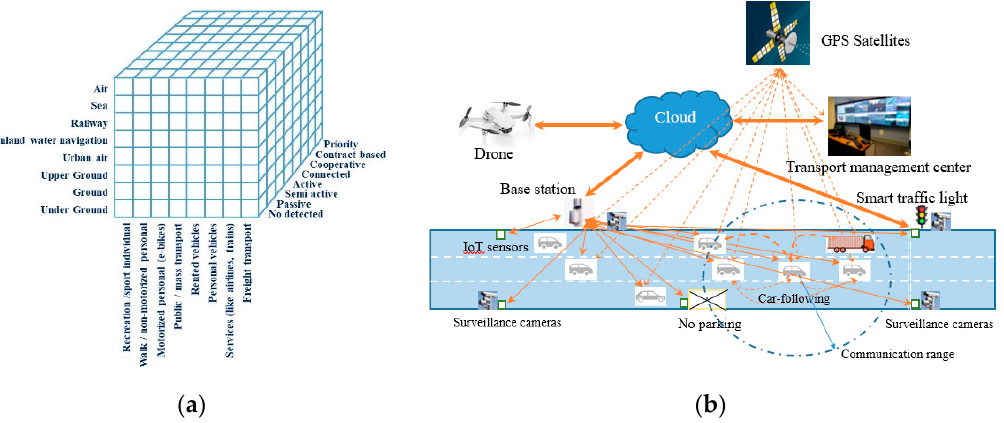
Figure 2. Hierarchical classification of the vehicles and primary information transmissions ( a ) cube of hierarchical structure, ( b ) system interconnections. IoT—Internet of Things.